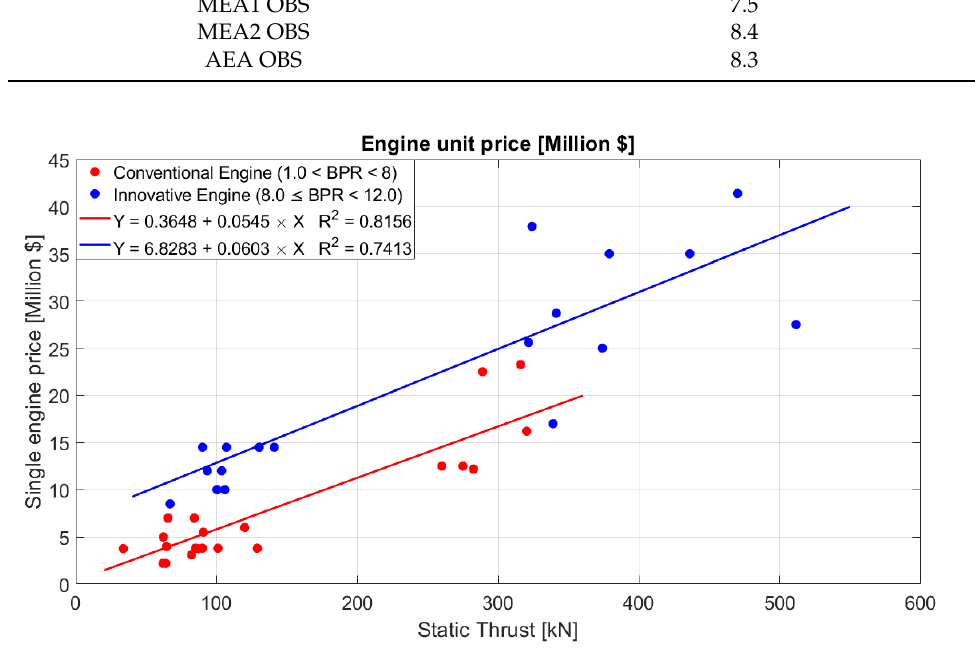
Figure 7. Conventional and innovative engine prices and static thrust trend comparison. The points are obtained from available public data.